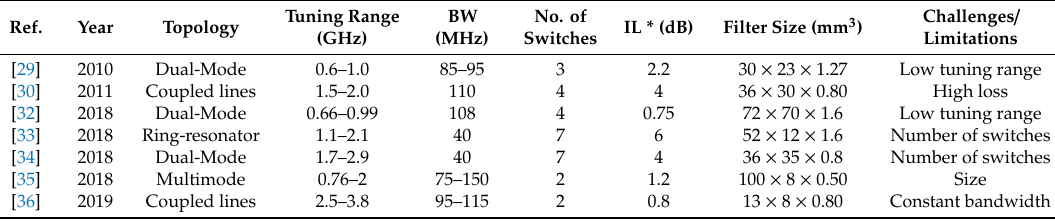
Table 1. Performance comparison between the surveyed reconfigurable filters.